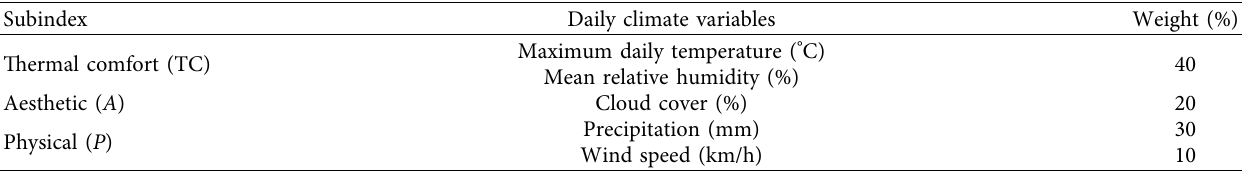
Table 1: Subindices of Scott’s Holiday Climate